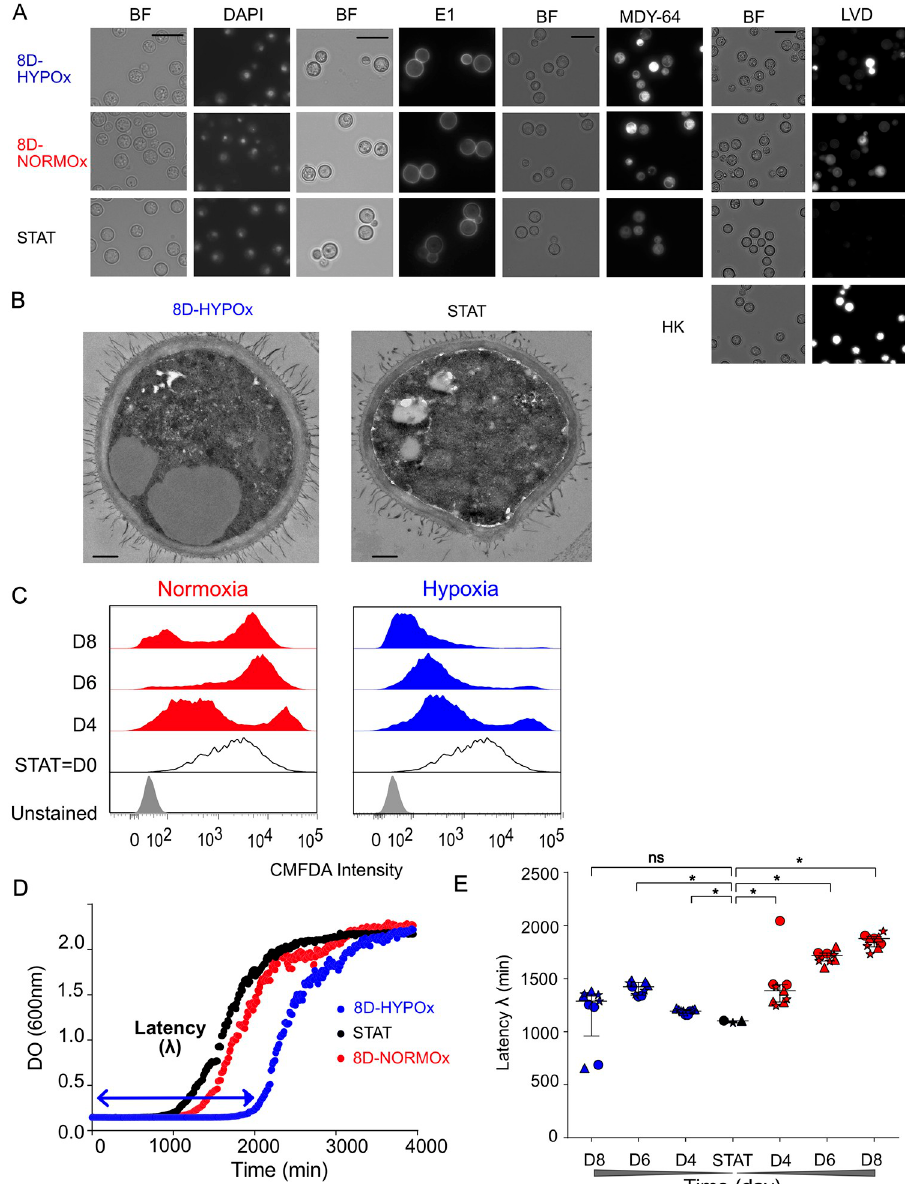
Fig 1. Cryptococcus . neoformans incubated for 8 days in hypoxia were intact with a low stress response and delayed growth. A . Cells recovered after 8 days in hypoxia (8D-HYPOx) were compared to those incubated in normoxia (8D-NORMOx), to stationary phase (STAT = D0) cells. DAPI staining (DAPI) showed intact cells with a nucleus; labeling with the E1 anti-glucuronoxylomannan monoclonal antibody showed similar staining pattern on the cryptococcal capsule in all conditions; vacuolar staining MDY-64 showing more intense staining in 8D-HYPOx/ 8D-NORMOx than STAT yeasts; LiveDead violet staining showing high viability in 8D-HYPOx (HK = heat killed yeasts, BF = bright field, bar = 10 μ m) B . Transmission electron microscopy of 8D-HYPOx and STAT showing the presence of large intracytoplasmic vacuoles (bar = 0.5 μ m) C . CMFDA labeling showed that 8D-HYPOx yeasts had decreased stress response over time compared to 8D-NORMOx. Representative from over 5 independent experiments. D . Representative growth curves in the different conditions with 8D-HYPOx showing an increased latency ( λ ) as calculated upon mathematical modelling. E . Latency of growth increased over time for 8D-HYPOx compared to STAT and 8D-NORMOx ( � p < 0.01, ns not significant). Experiments were done 3 times independently (each experiment is identified with a different symbol, circle, triangle, star). Each replicate represents the value of the latency ( λ ) for each biological replicate as the mean of 3 technical replicates. Medians and interquartile range (IQR) are represented.